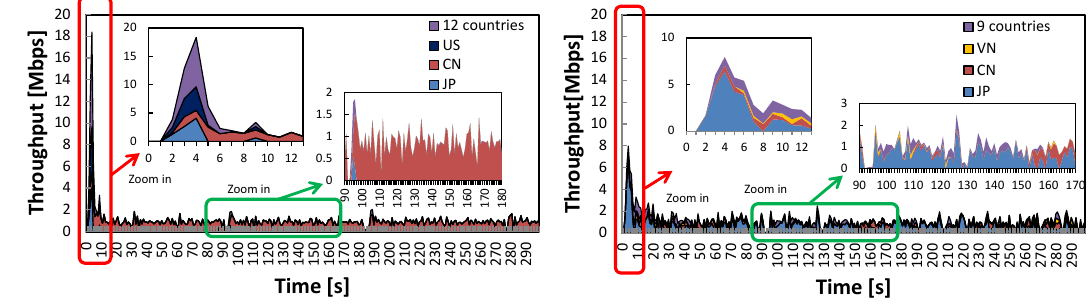
Fig. 8. Temporal change of throughput for SopCast without and with packet loss method; the left side shows the result in normal case without packet loss method, and the right side shows the result when forcing 20% packet loss to overseas